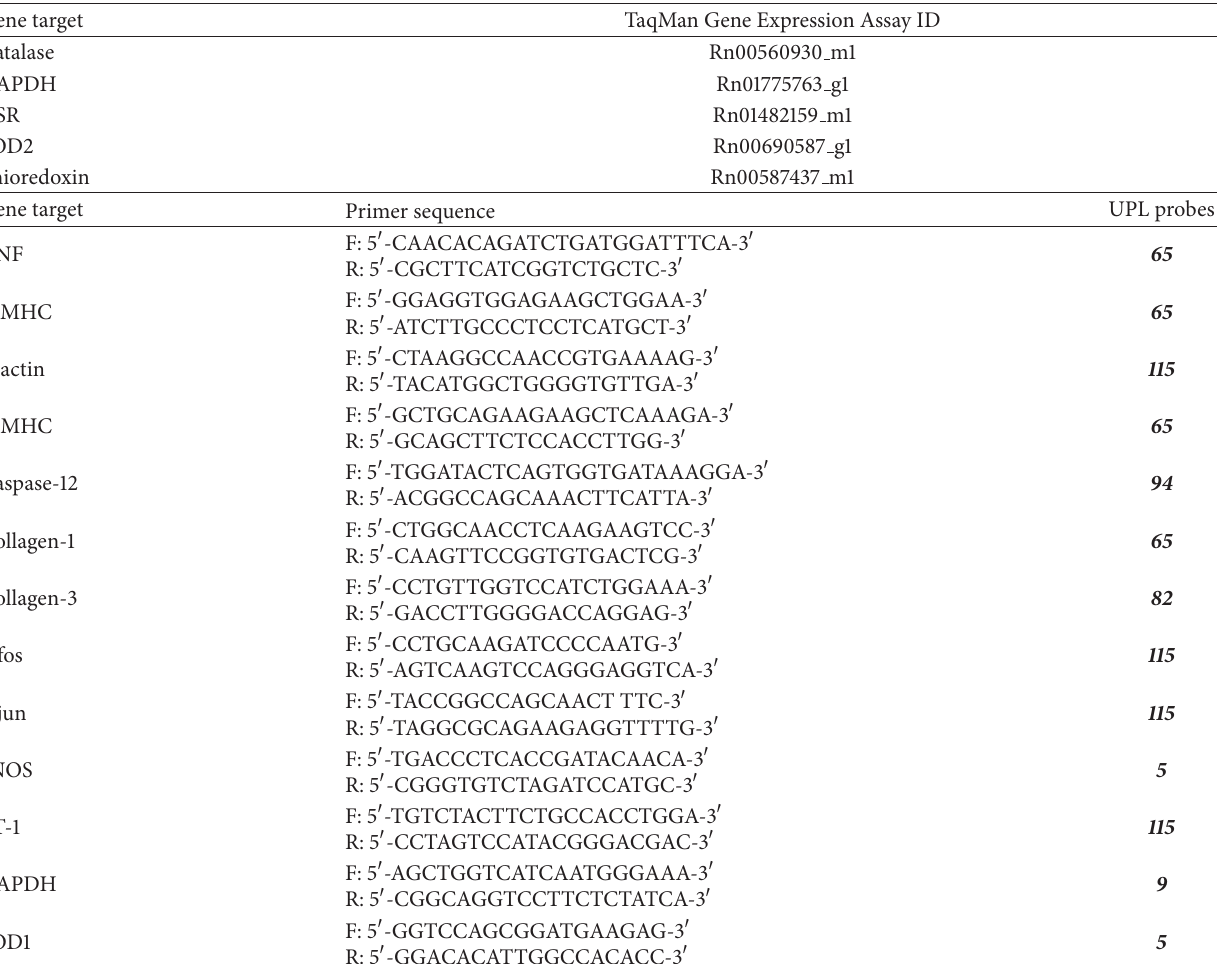
Table 1: Identification numbers of TaqMan Gene Expression Assays and sequence for the forward (F) and reverse (R) primers (from 5 󸀠 to 3 󸀠 ) and Universal Probe Library (UPL) probes used in quantitative real time